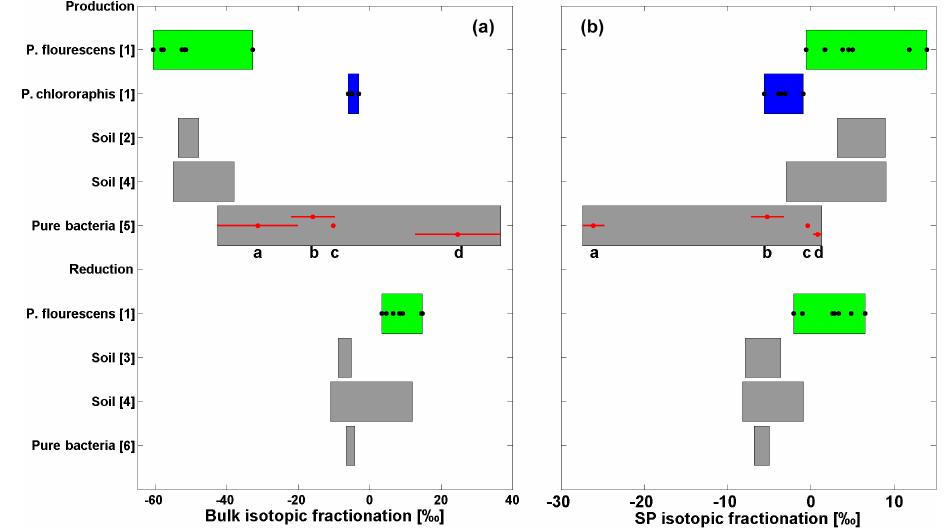
Figure 7. (a) Bulk and (b) SP isotopic fractionation calculated from the continuous measurements with P. fluorescens (green) and P. chloro- raphis (blue), respectively. Both the production and reduction isotopic fractionations are shown and compared with previously presented results. [1] This study, [2] Well and Flessa (2009a), [3] Well and Flessa (2009b), [4] Lewicka-Szczebak et al. (2014, 2015), [5] (a) Thompson et al. (2004), (b) Toyoda et al. (2005), (c) Ostrom and Ostrom (2011), (d) Sutka and Ostrom (2006), and [6] Ostrom et al.